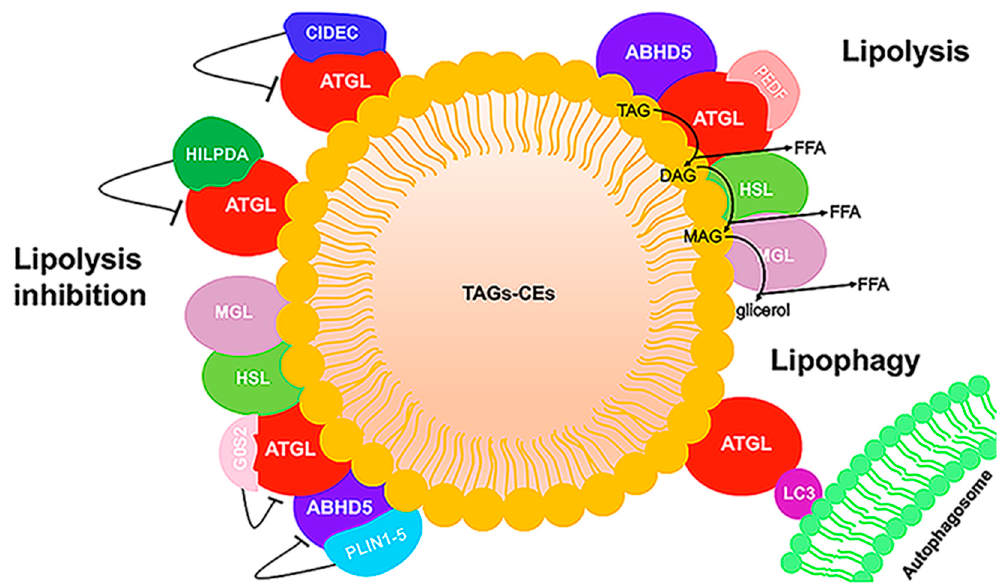
Figure 4. LD schematic representation. LDs have a core composed of triacylglycerol (TAG) and cholesteryl ester (CE), surrounded by a phospholipid monolayer. Some proteins binding to the phospholipid monolayer are involved in neutral lipid metabolism. In the stimulated condition, ABHD5 binds to and activates ATGL, and TAG is hydrolyzed sequentially by ATGL, hormone-sensitive lipase (HSL), and monoacyl-glycerol lipase (MGL) to generate fatty acid (FA) and glycerol. In hepatic and muscle cells, pigment epithelium-derived factor (PEDF) stimulates lipolysis by binding ATGL. In the unstimulated state, lipolysis is inhibited by the association of ATGL with G0/G1 switch gene 2 (G0S2), hypoxia-inducible LD-associated protein (HILPDA), and cell death activator CIDE-3 (CIDEC) and by the interaction between ABHD5 and perilipin (PLIN) proteins. In addition, ATGL can interact with LC3, an autophagic protein. Direct ATGL–LC3 binding can facilitate correct ATGL localization on the LD surface.